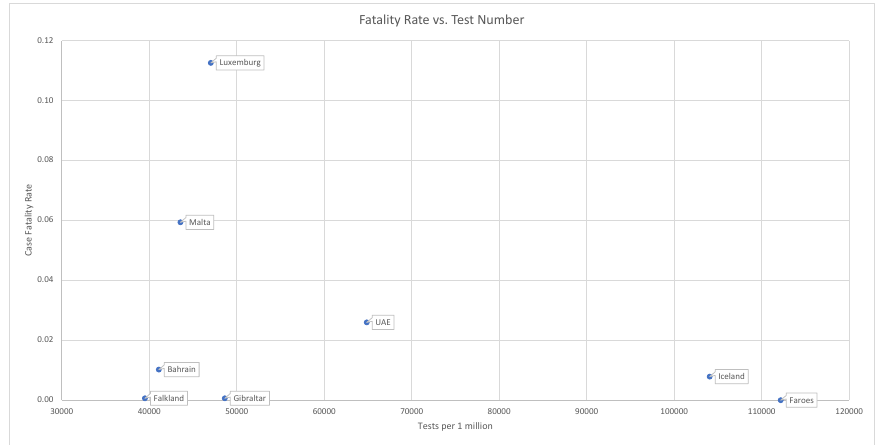
Figure 11. Countries that have administered tests to a broader portion of the population tend to report lower case fatality rates. This is consistent with the fact that θ << 1. Source: https: //ourworldindata.org/.